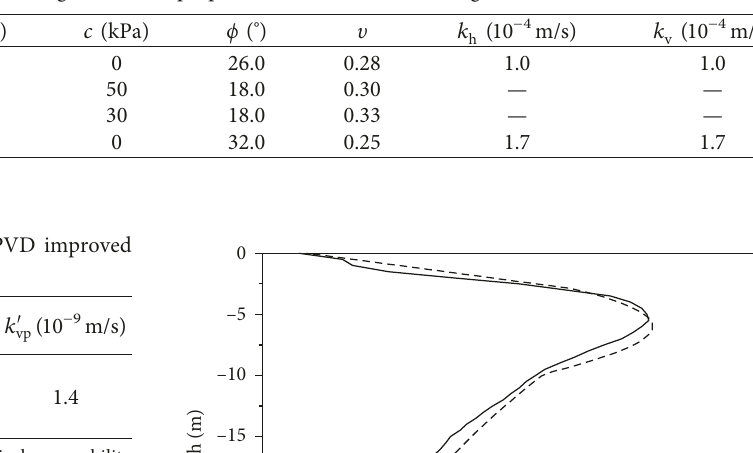
Table 2: Summary of the geotechnical properties of embankment fillings.